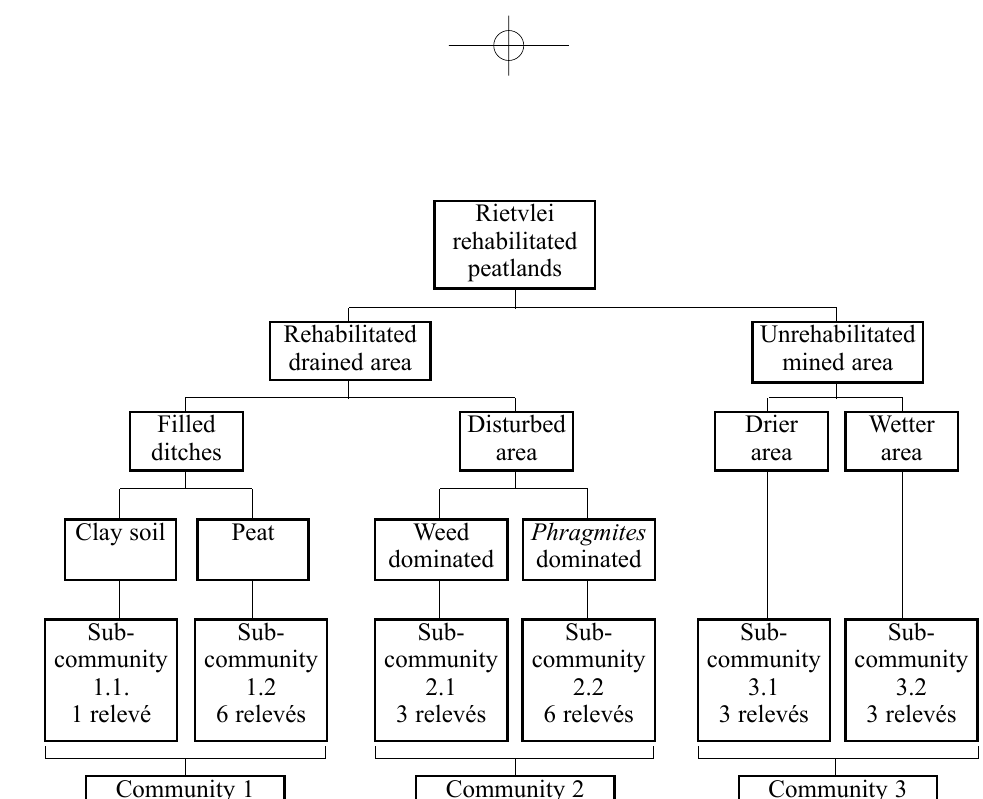
Fig. 1. Dendrogram showing the hierarchy of TWINSPAN divisions for the vegetation data of the rehabili- tated peatlands on Rietvlei Nature Reserve on the 2001